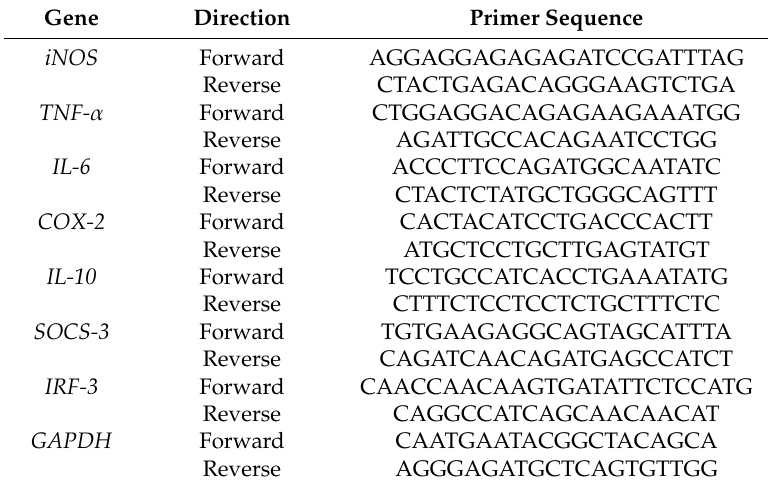
Table 1. Primer sequence used in quantitative